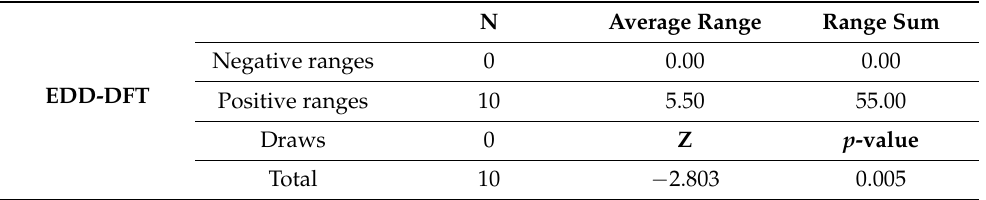
Table A15. Comparative analysis between DFT and EDD in terms of average